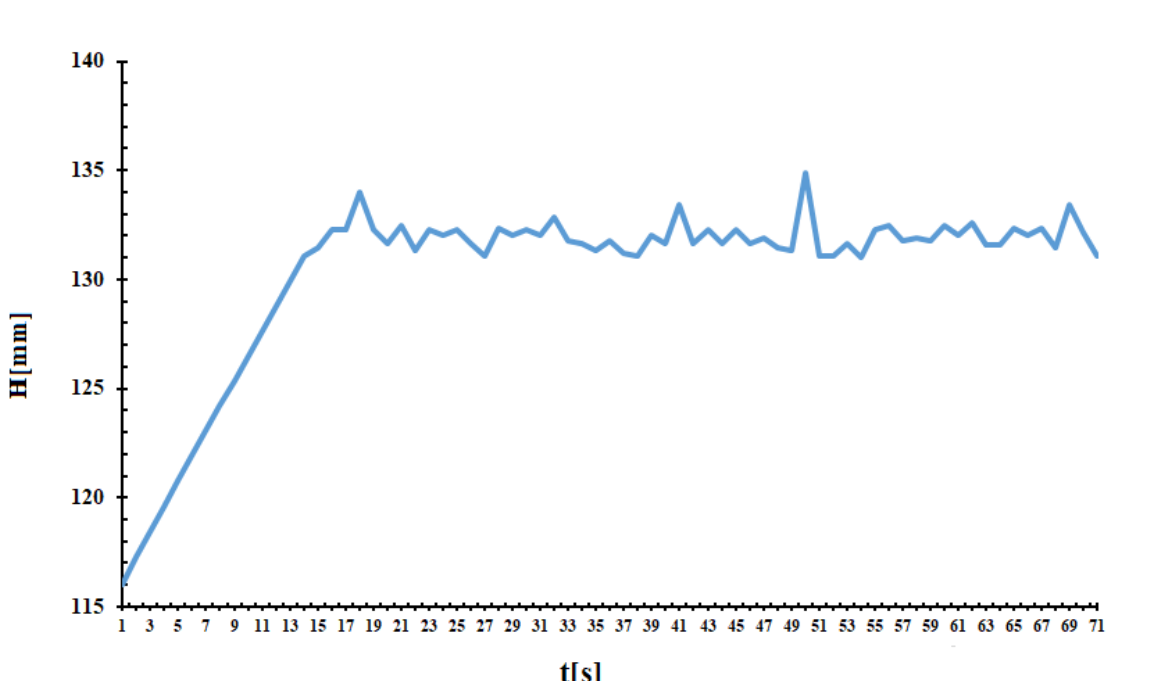
Figure 8. Evolution of the fluidized-sand bed height as a function of time, for a fluidization rate of 0.07 m · s − 1 . Numerical results obtained with a stack of initial height H 0 = 115 mm.